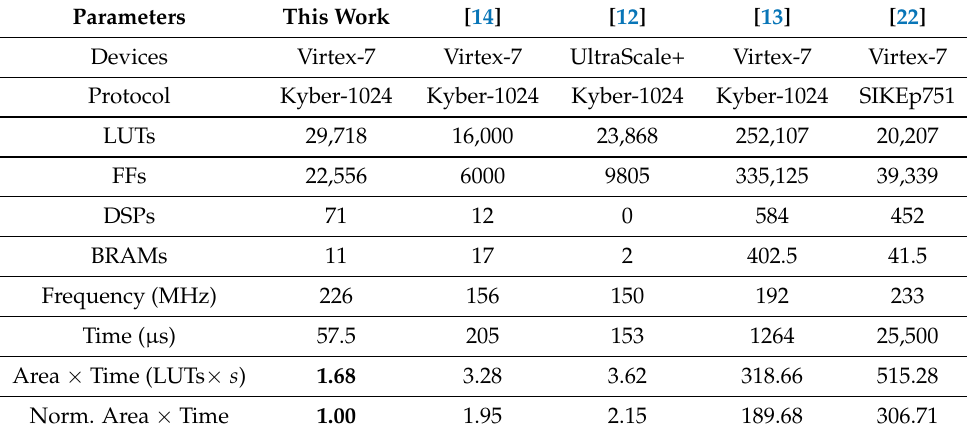
Table 3. Performance comparison with existing schemes in NIST security level